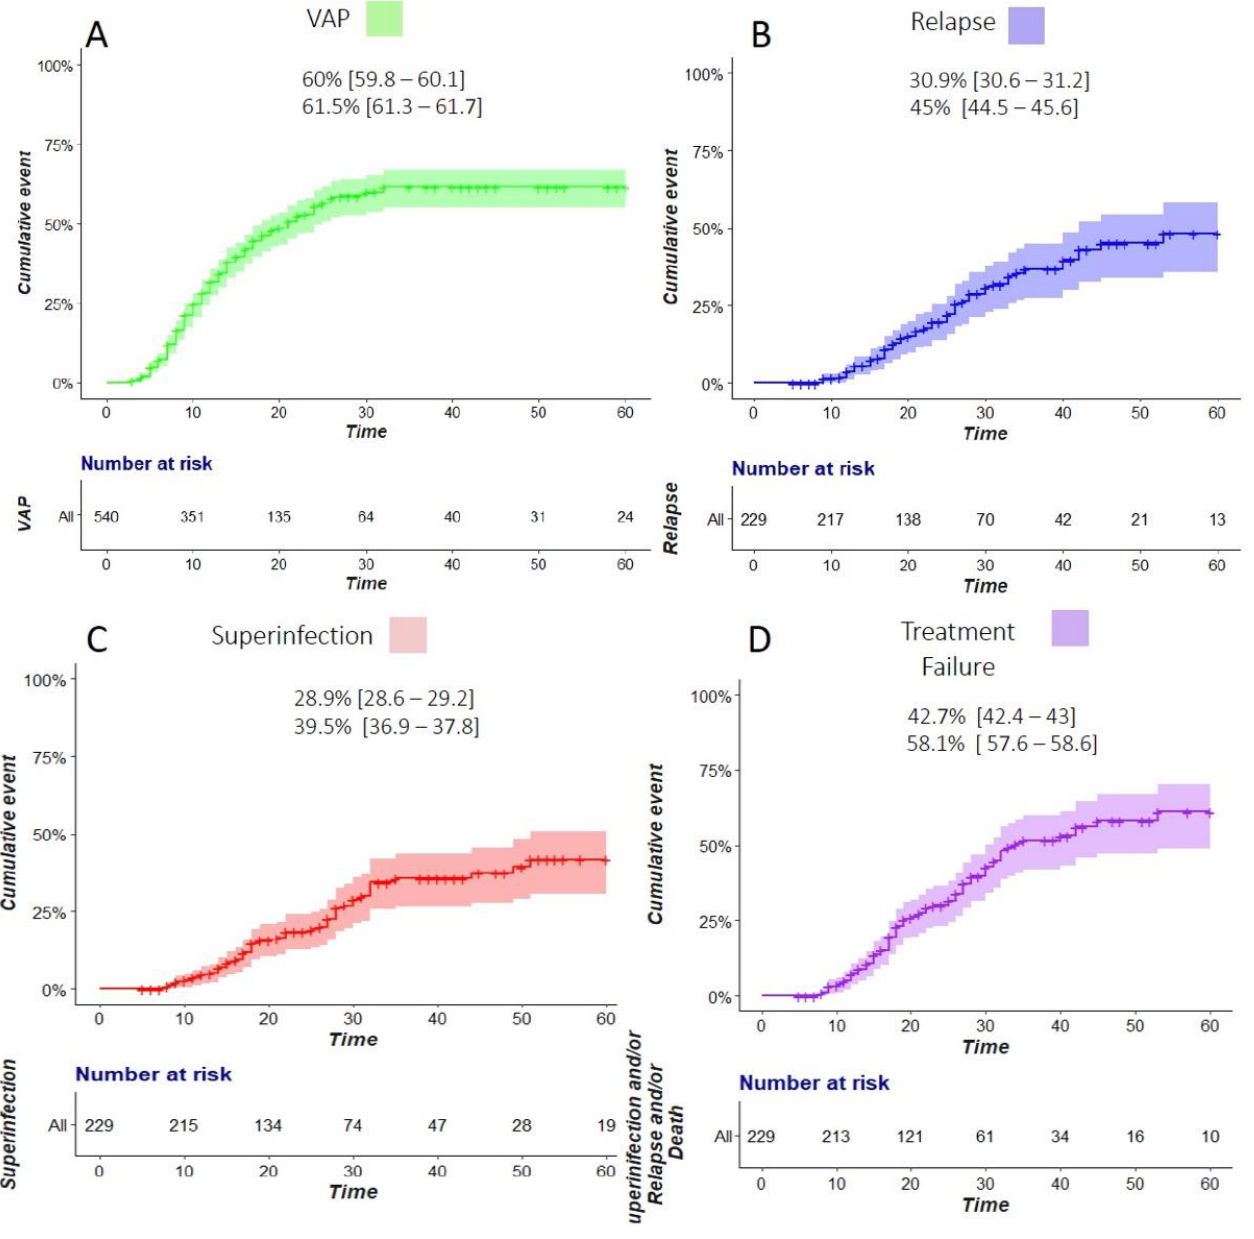
Figure 1. Cumulative incidence of ventilator-associated pneumonia (VAP) ( A ), relapse ( B ), superin- fection ( C ), and treatment failure ( D ). The estimations at Day 30 and Day 60 are displayed for each respective outcome (% [95% confidence interval]). Table 2. Main outcomes according to the occurrence of ventilator-associated pneumonia (VAP).